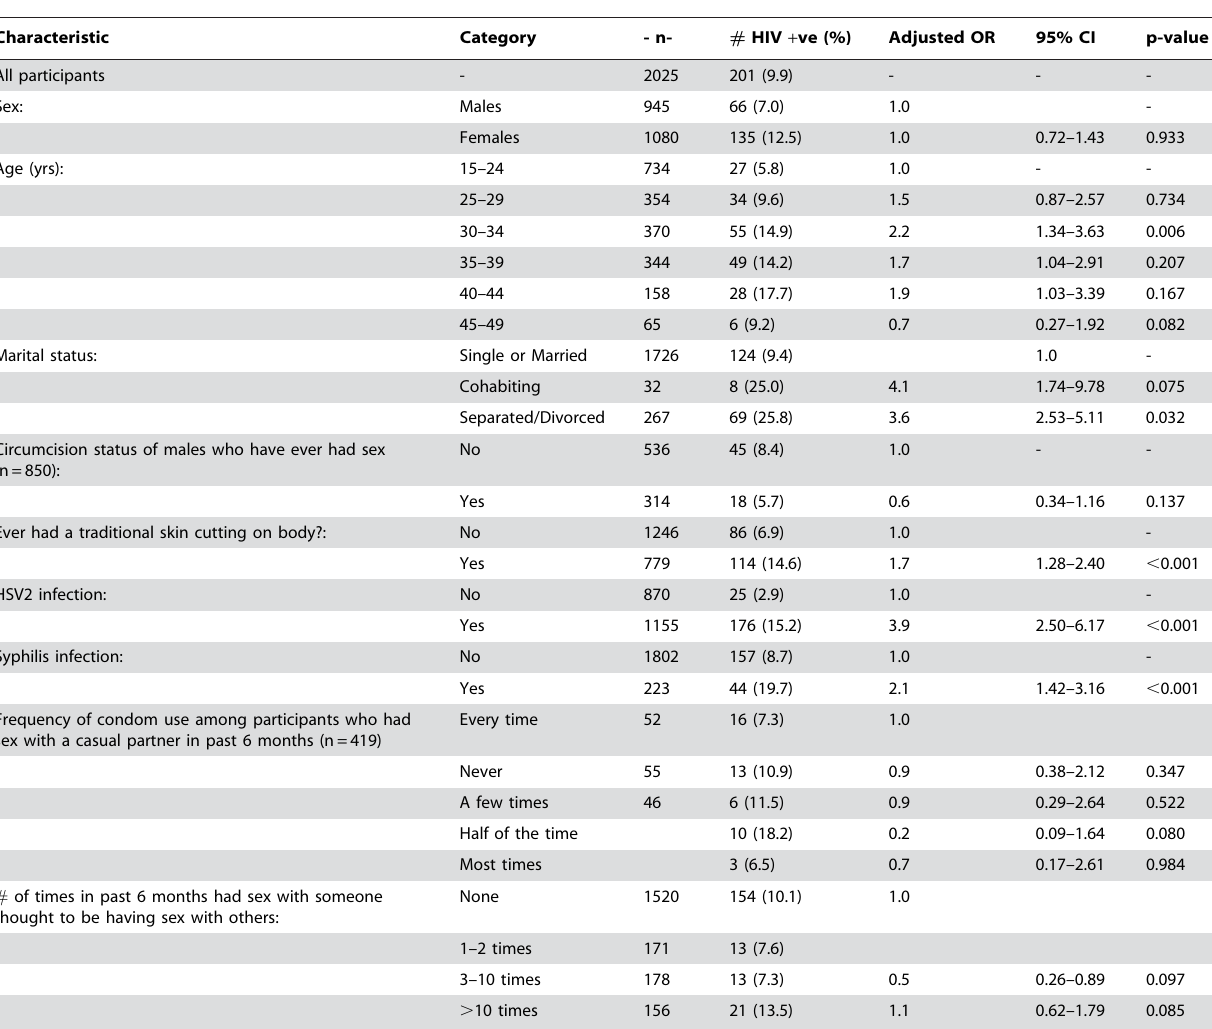
Table 2. Prevalence of HIV infection, by baseline characteristics of